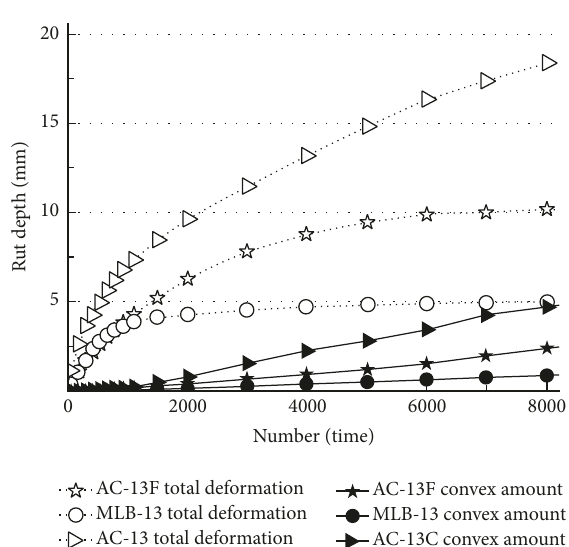
Figure 8: Decomposition of DWPA rutting